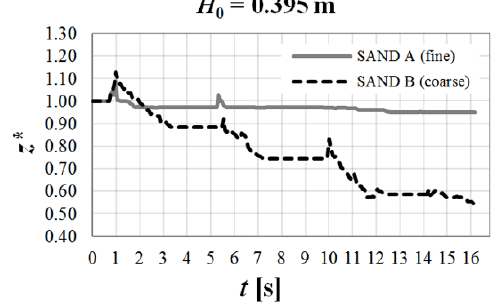
Figure 3. Experimental time evolution of z * at the dike centerline for Tests A2 and B2.